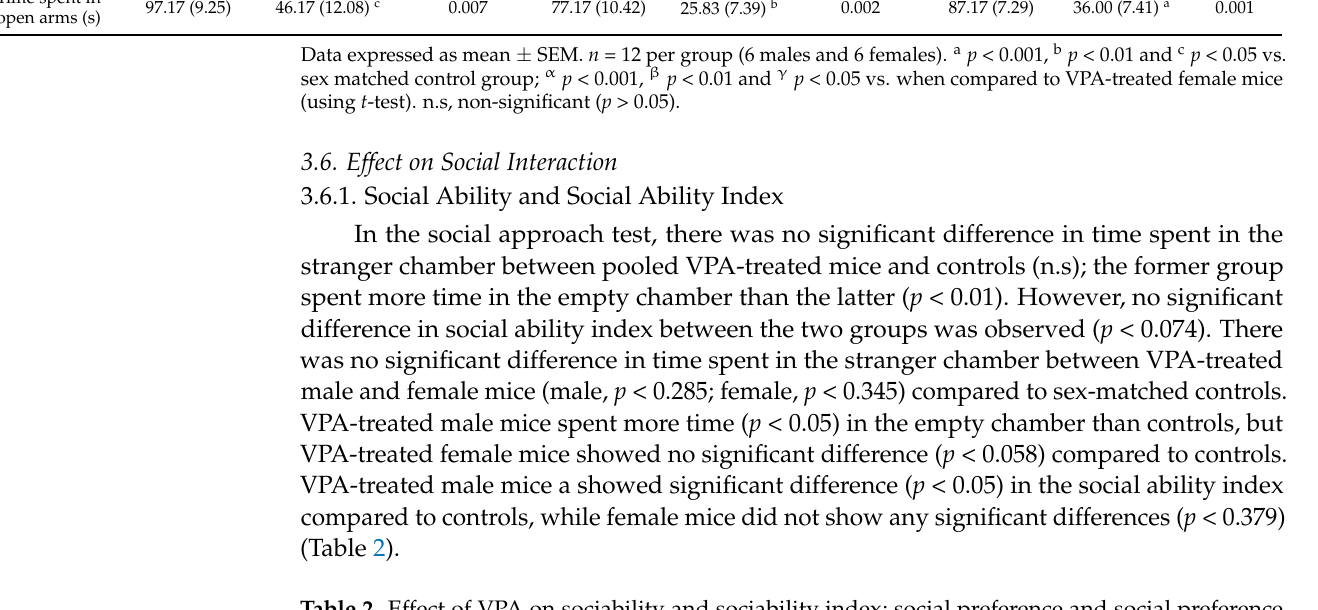
Table 2. Effect of VPA on sociability and sociability index; social preference and social preference index determined using three-chamber social interaction testing